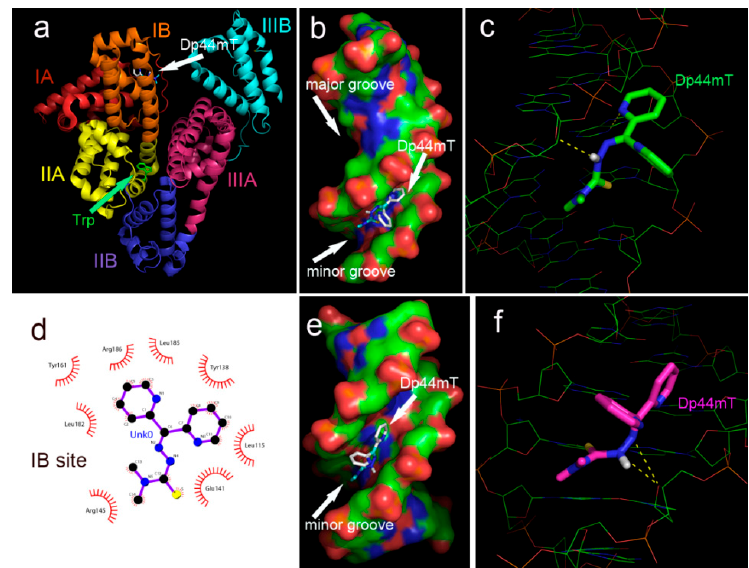
Figure 10. The interaction of Dp44mT with HSA and DNA. ( a ) Dp44mT located at the IB site; ( b ) Dp44mT located in the minor groove of TA-enriched DNA; ( c ) interaction of Dp44mT with the adjacent nucleoside of TA-enriched DNA; ( d ) interaction of Dp44mT with environmental residues (in the figure Unk0 = Dp44mT); ( e ) Dp44mT located in the minor groove of GC-enriched DNA; and ( f ) interaction of Dp44mT with the adjacent nucleoside of GC-enriched DNA. The eye-like curved dark red lines represent the hydrophobic residues in contact with Dp44mT as previously described [16].